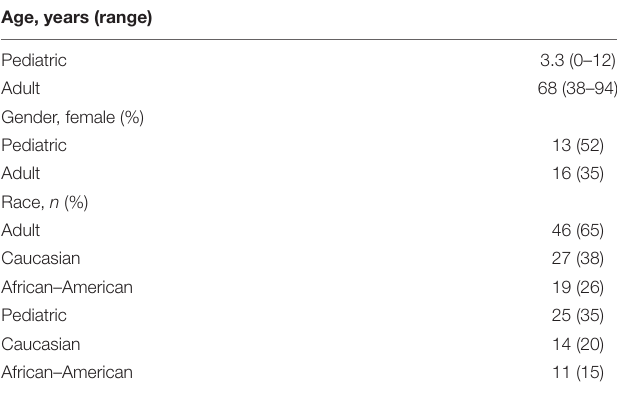
TABLE 1 | Description of demographic data for human temporal bone specimens.